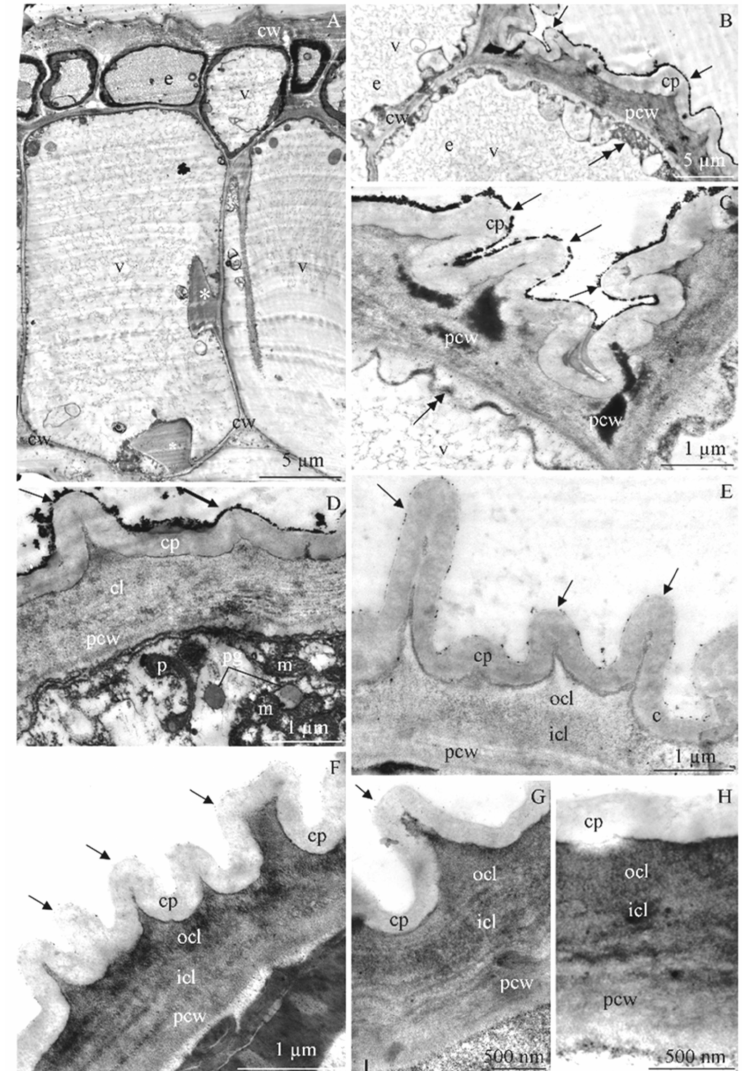
Figure 6. ( A – H ). Fragments of epidermis ( A – H ) and endothecium ( A ) cells in R. idaeus ‘Glen Ample’ ( A , H ), ‘Laszka’ ( B , C ), ‘Radziejowa’ ( D ), ‘Polka’ ( E ), ‘Polana’ ( F ), and ‘Pokusa’ ( G ): ( A )— thick outer cell wall (cw) of small vacuolated epidermis cells (e), large endothecium cells (a) with thick evaginations (asterisk) of the inner periclinal and anticlinal walls, ( B , C )—epidermis cells (e), cell walls (cw), evaginations of the outer wall (arrows), cuticle proper layer (cp), the other part of the cell wall (pcw), parietal cytoplasm (double-headed arrow), vacuole (v), ( D )—evaginations of the cell wall (arrow), a band of cuticle proper (cp) with homogeneous thickness and lamellar structure, reticulate cuticle layer (cl), the other part of the cell wall (pcw), mitochondria (m), plastoglobules (pg), amorphous plastid (p), ( E – H )—evaginations of the cell wall (arrow) with varied height ( E , F ), visible lamellar cuticle proper (cp), outer (ocl) and inner (icl) reticulate cuticle layer, the rest of the cell wall (pcw); ( A – H